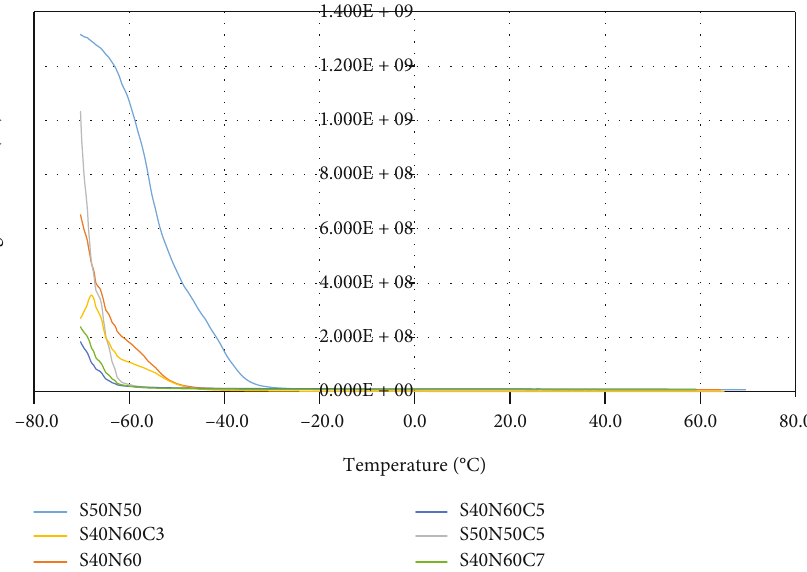
Figure 17: Storage modulus as a function of temperature (T) for rubber